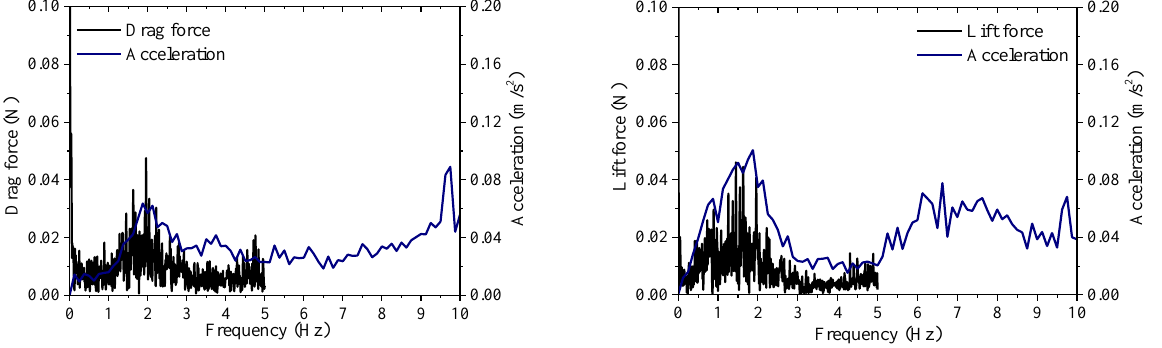
Figure 12. Spectrum diagrams of the aerodynamic force (at wind attack angle of 30°) and vibration accelerations in the corresponding direction under test condition of no end plates and viaduct high- way.